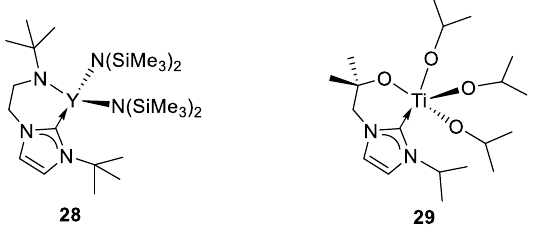
Figure 8. The Y and Ti complexes bearing heteroatom-tethered NHC ligands used for ring-opening polymerization (ROP) of